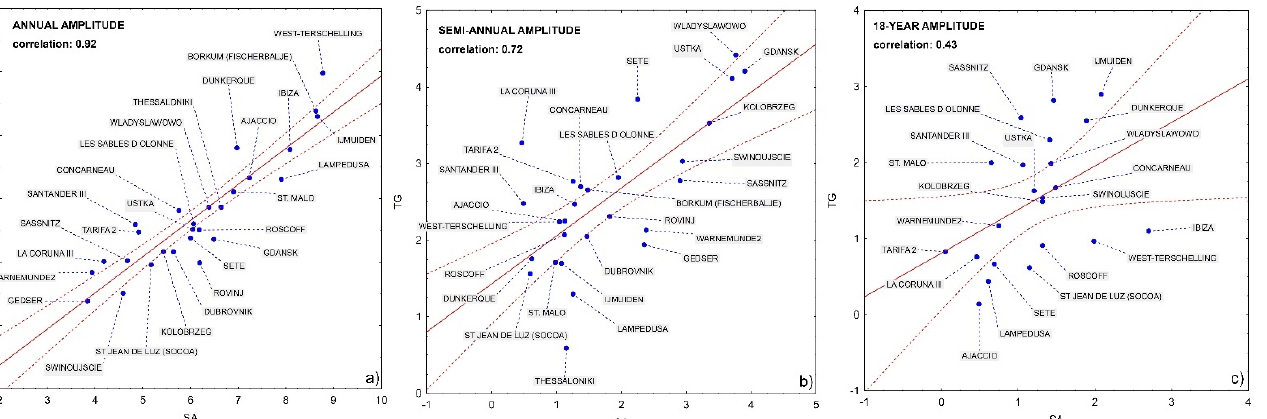
Figure 3. ( a ) Annual, semiannual and 18.61-year harmonics functions based on TG data for 1946 – 2017. ( b ) Annual, semiannual and 18.61-year harmonics functions based on SA data for 1993 – 2017. ( c ) Annual, semiannual and 18.61-year harmonics functions based on TG data for 1993 – 2017 in the Sassnitz station. The units are in centimetres.